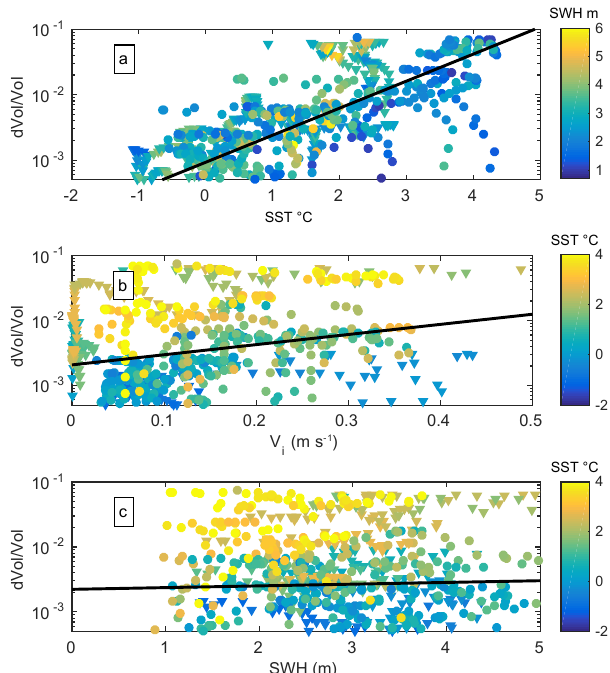
Figure 8. (a) Relative volume loss d V/V as a function of SST. The colour represents the significant wave height in m. (b) d V/V as a function of the iceberg velocity. The colour represents the SST in ◦ C. (c) d V/V as a function of significant wave height. The circles correspond to C19a and the triangles to B17a. The red lines repre- sent the regression lines. The ordinate scale is